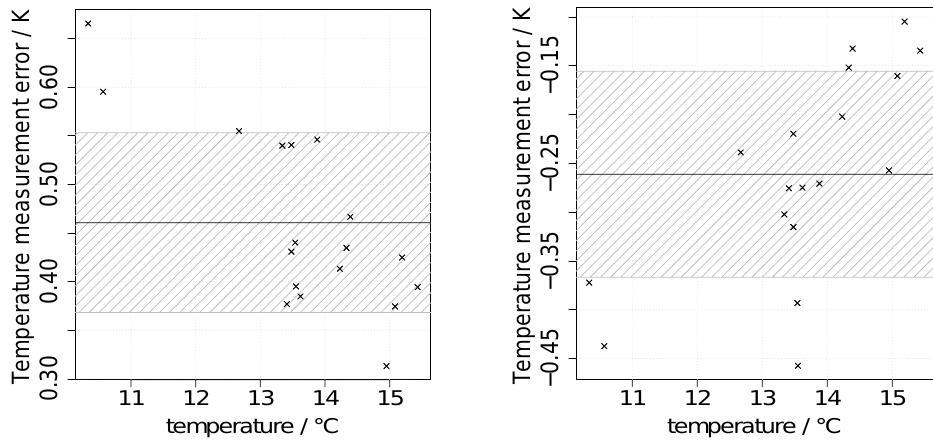
Fig. 9. Errors of FWPRT (left panel) and thermocouple measurements (right panel) compared to tower temperature measurement. Ten-minute averages of RPA and tower measurements at the same altitude and time are used to calculate the error. The solid black line marks the mean error. The shaded area visualizes the standard deviation.